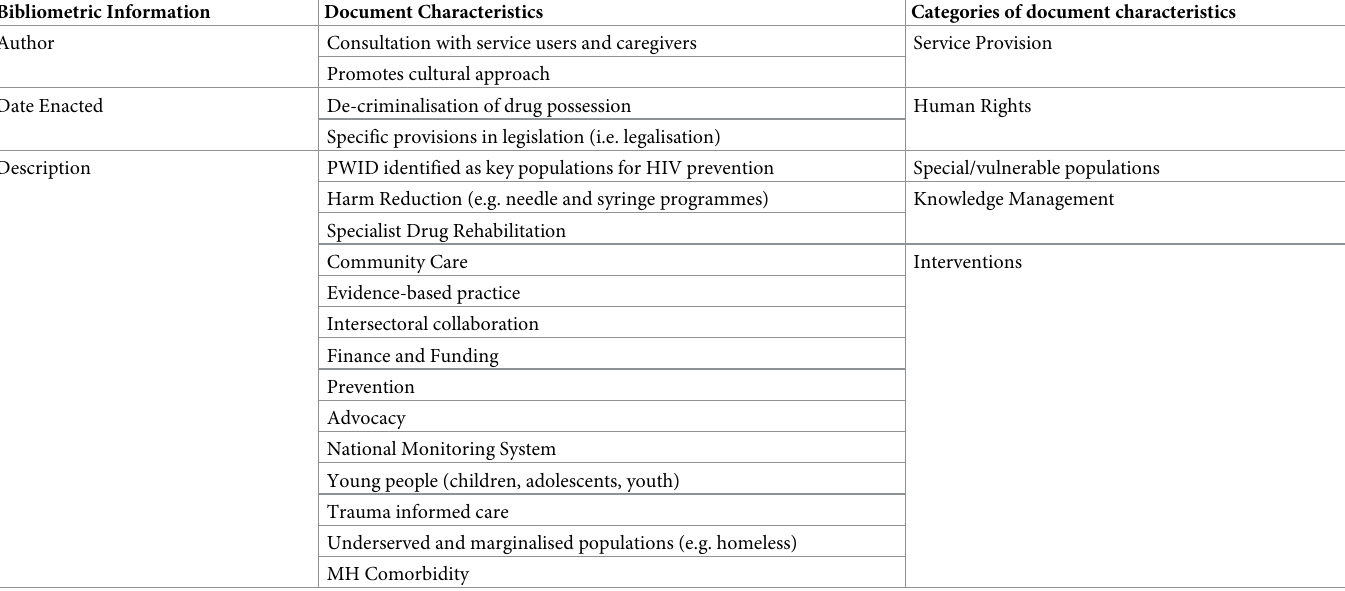
Table 3. Policy & strategic document